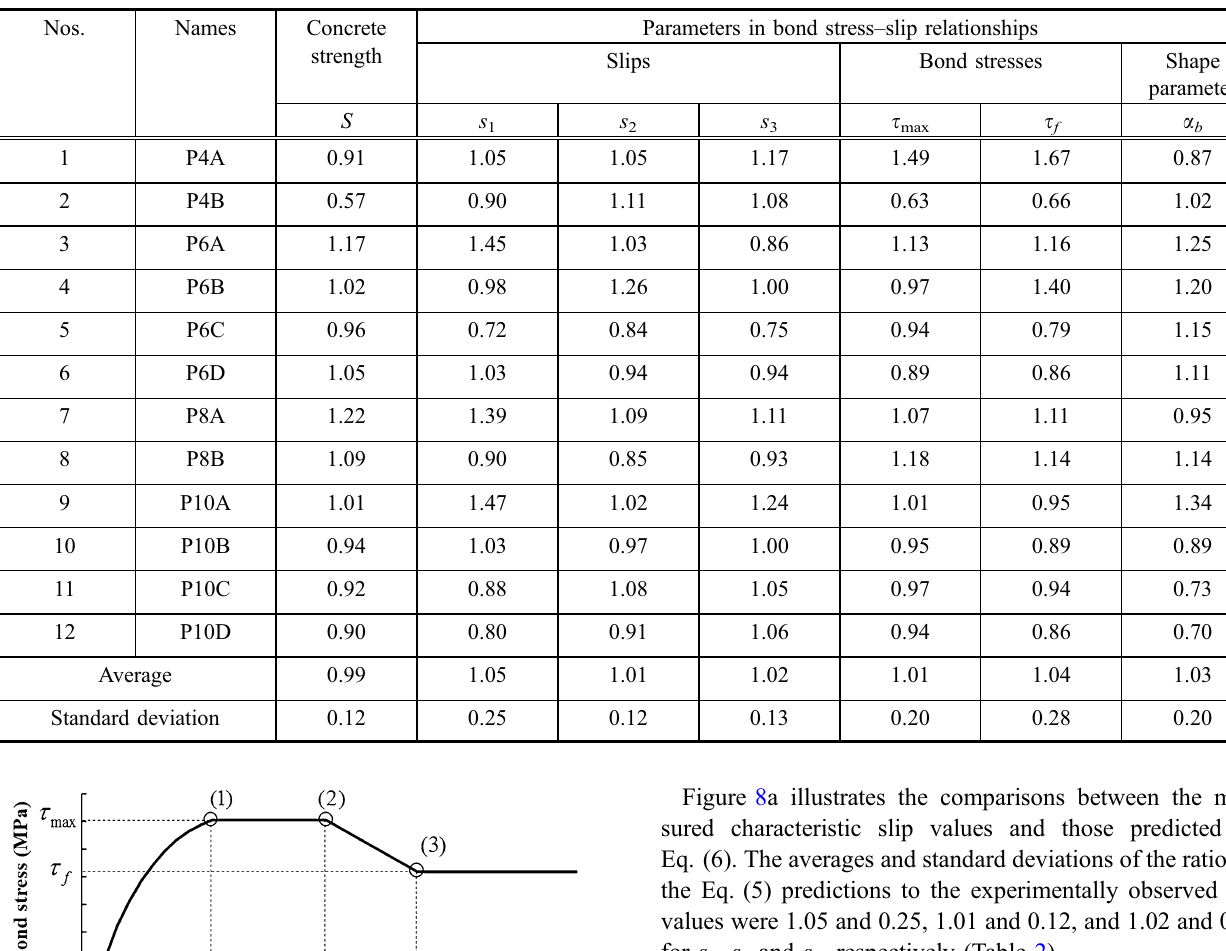
Table 2 Statistical parameters for the ratios of the model prediction to the test results. Nos.